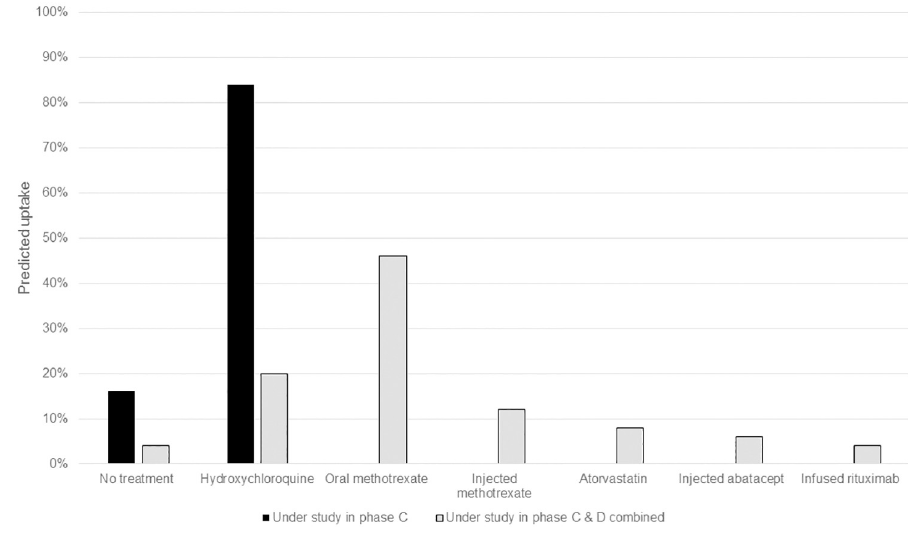
Fig 2. Predicted uptake: Treatments under